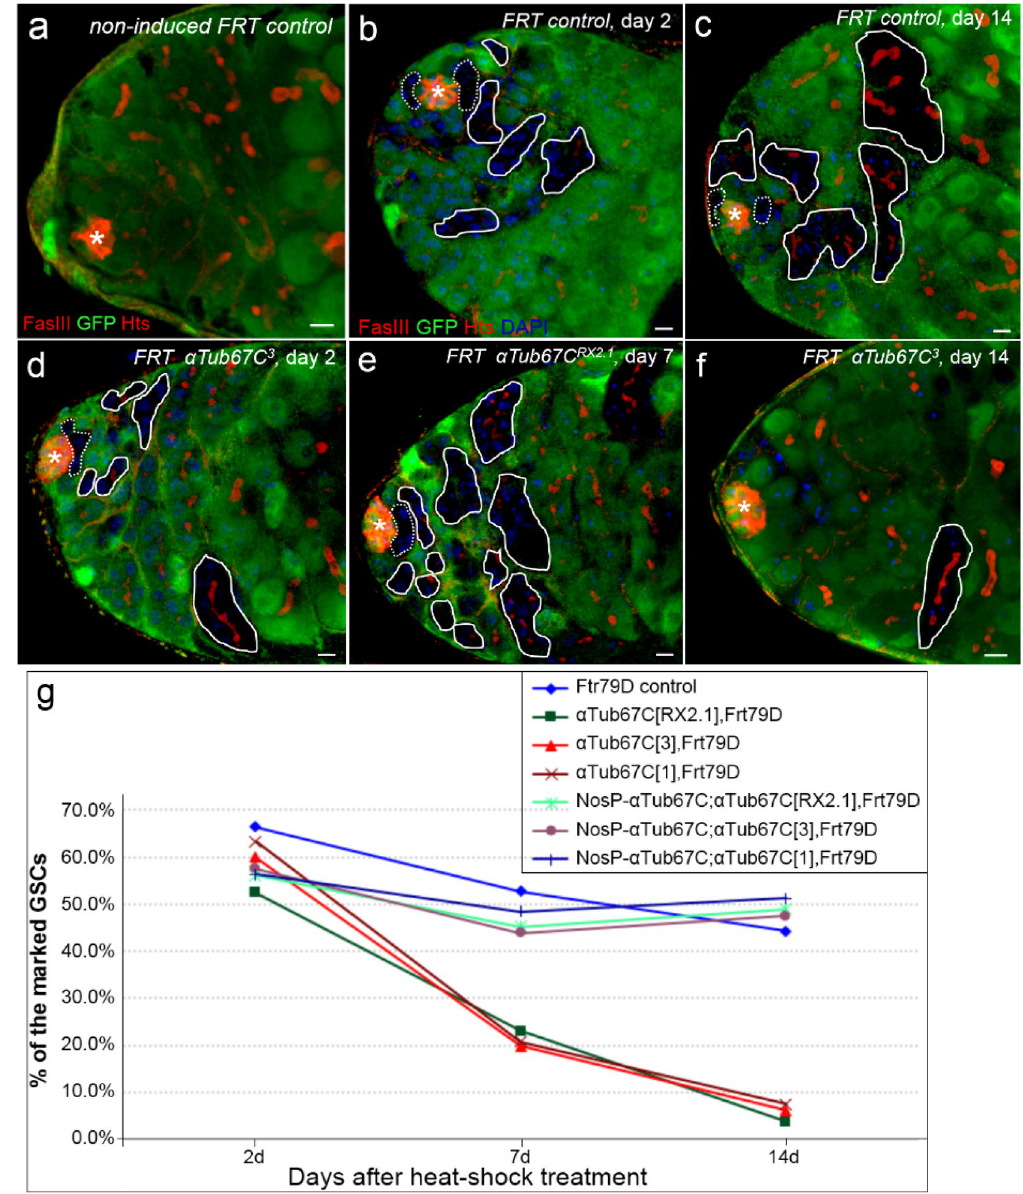
Figure 2. Intrinsic mutation of αTub67C leads to GSCs loss in Drosophila testis. ( a ) Testis from non-heat shock FRT control. Testes from FRT control ( b , c ) and FRT αTub67C flies ( d – f ) were collected at the indicated days after heat-shock treatment. All testes were stained with anti-Fas III antibody (red) to label the hub ( a red cluster of cells), anti-Hts antibody (red) to visualize fusomes, and anti-GFP antibody (green) to show the αTub67C expression pattern. ( b – f ) Testes with DAPI dye (blue) staining to mark the nuclei. Hubs were noted by asterisks. GSCs clones (indicated by broken lines) and GB/spermatogonia clones (indicated by circles) were identified by lack of GFP expression. ( g ) Percentages of negatively GFP-marked GSC clones in FRT control and αTub67C mutant alleles at day 2, 7 and 14. Compared with FRT control, the percentages of marked GSCs (lack of GFP expression, GFP-) in αTub67C mutants were dramatically declined. Scale bars: 5